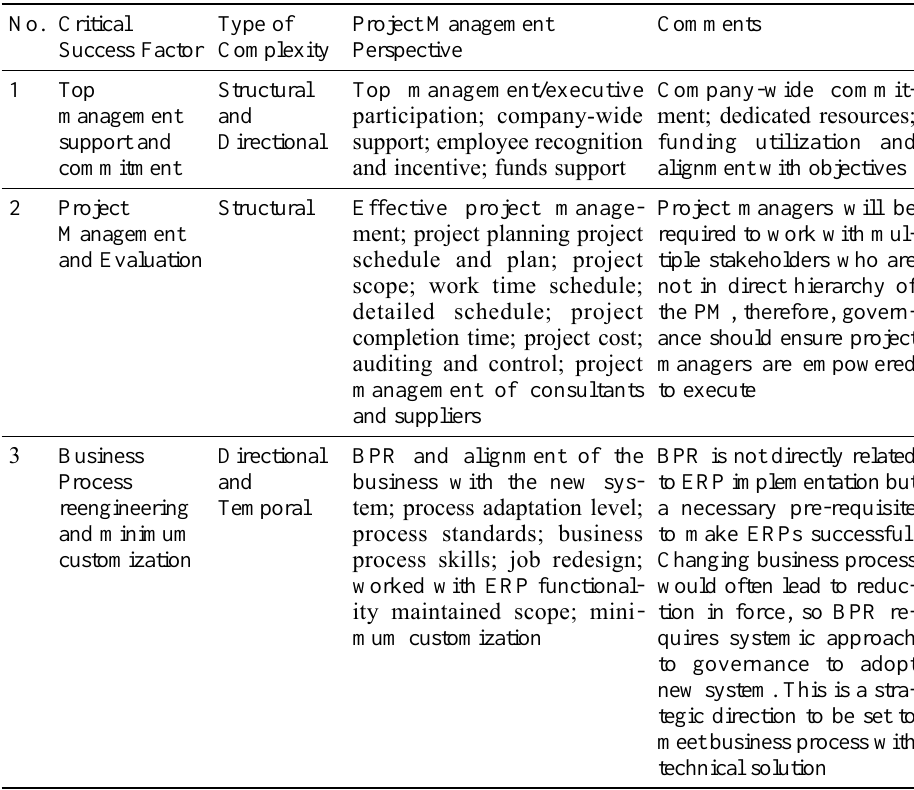
Table 1. Evaluation of complexities of CSFs (CSFs only adopted from Moon (2007)) No.